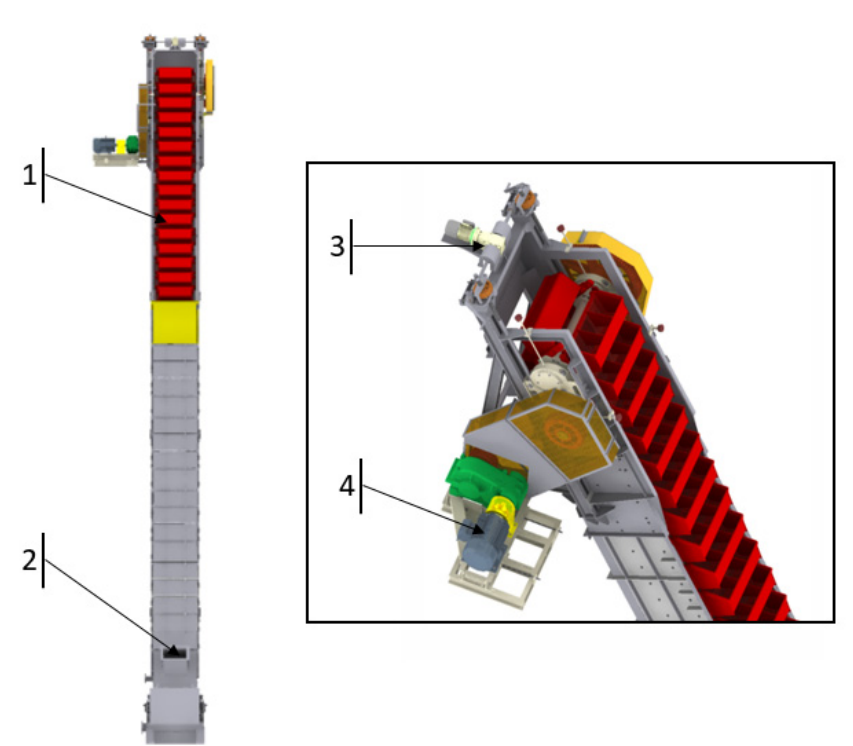
Figure 2. Diagram of the “Komag” bucket conveyor: 1—chain with buckets, 2—material loading zone, 3—material dumping zone, 4—drive.